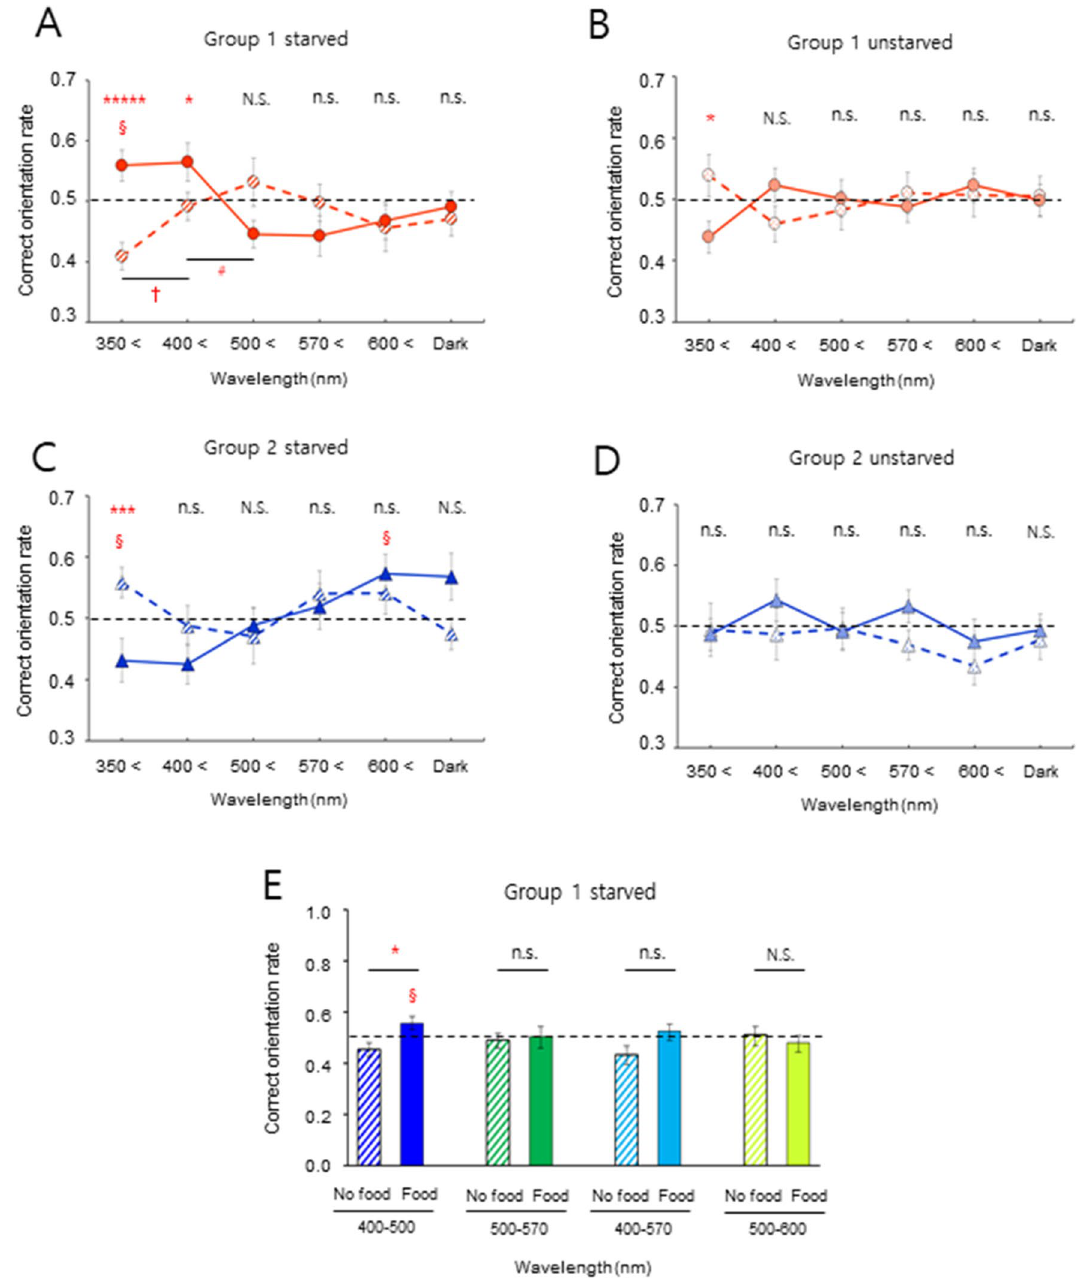
Figure 2. Blue light plays a pivotal role in wavelength-dependent magnetic orientation. ( A – D ) Correct magnetic orientation rate in Group 1 ( A , B ) or Group 2 ( C , D ) subjects under starved and unstarved conditions. The data for > 350 nm light were the same as those in Fig. 1, B or D. Data points connected by straight lines and dashed lines were obtained from food-association and no-association, respectively. §, P < 0.05 by one- sample t- test; *, P < 0.05; ***, P < 0.005; *****, P < 0.0005; and n.s., not significant by paired sample t- test between the corresponding data from food- and no-association; #, P < 0.01 by paired sample t- test between the data from > 400 nm and > 500 nm in food-association. ( E ) Correct magnetic orientation rate with the different light conditions in Group 1 starved. §, P < 0.05 by one-sample t- test; *, P < 0.05; and n.s., not significant by paired sample t- test; †, significant between the data from > 350 nm and > 400 nm in no-association; N. S., not significant by a percentile bootstrap analysis (see Appendixes S1 and S2); horizontal dashed lines, 0.5 for correct orientation rate; error bars, standard error of the mean (SEM). Group 1, n = 20 and Group 2, n =